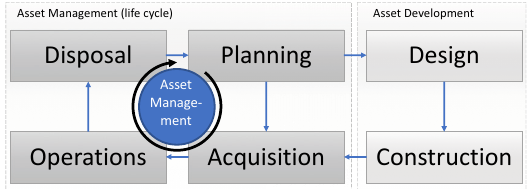
Figure 1. The asset lifecycles stages are categorised into asset management (disposal, planning, acquisition and operations) and asset development (design and construction) (Austroads,